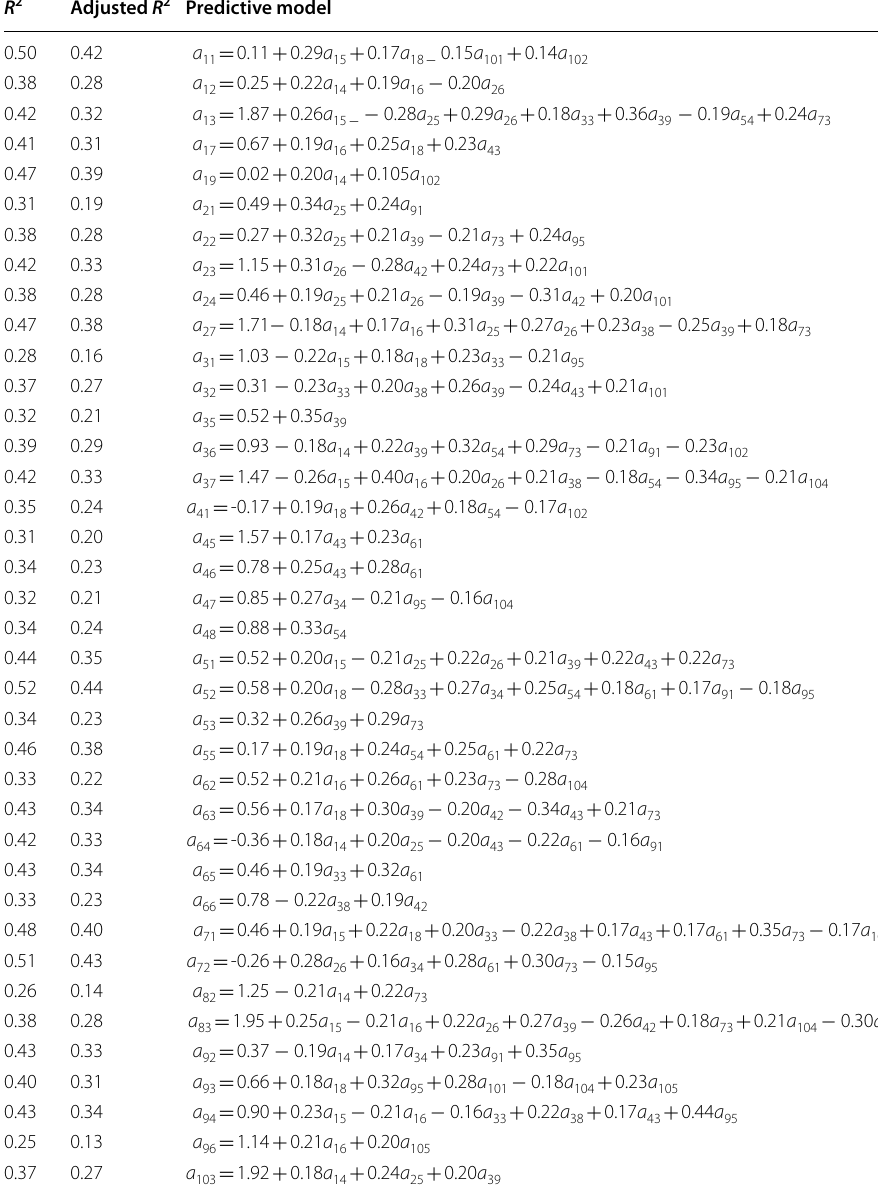
Table 4 Predictive model of the planning process threats dimension R 2 Adjusted R 2 Predictive model